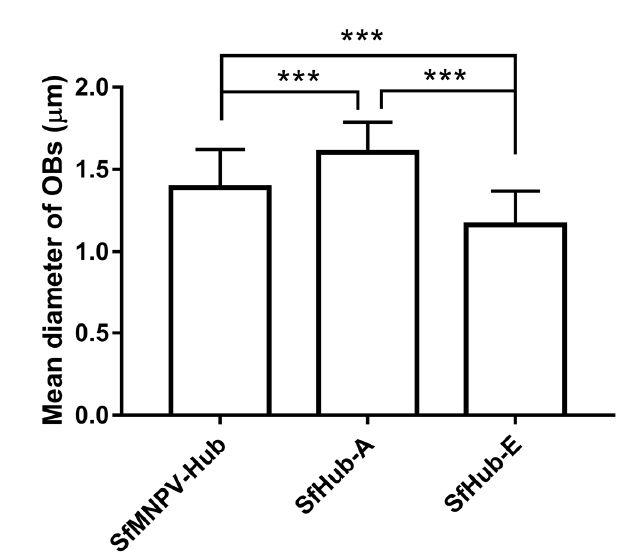
Figure 3. Diameter of OBs of SfMNPV-Hub ( n = 128), SfHub-A ( n = 111), and SfHub-E ( n = 175). Error bars represent the standard deviation (SD). *** represents p < 0.001 by Tukey’s honestly significant difference (HSD).